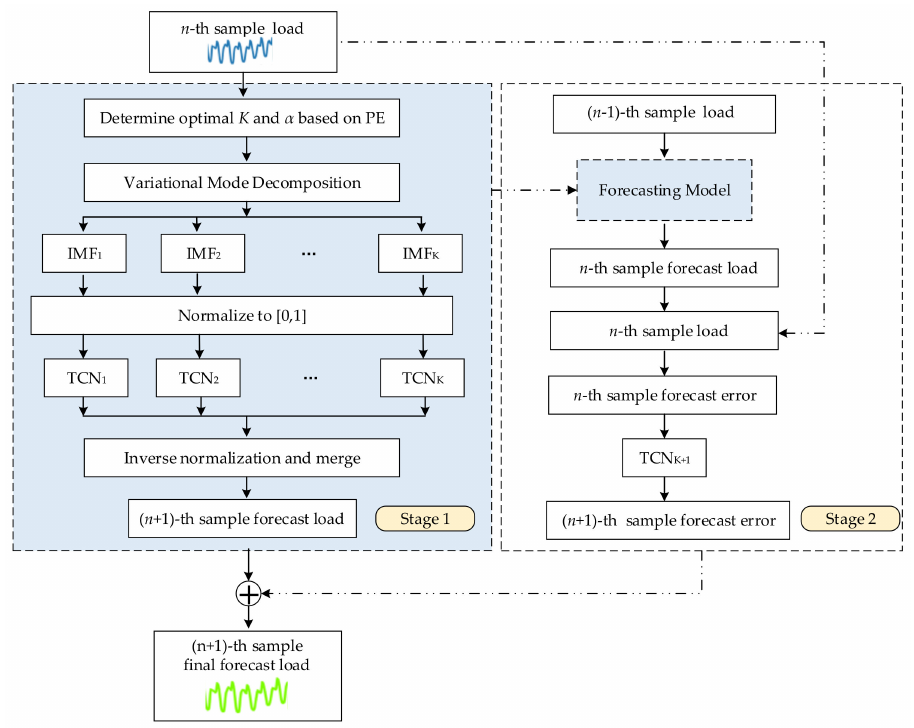
Figure 5. The whole process of the proposed forecasting model.